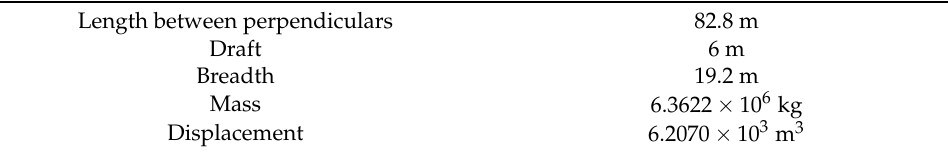
Table 3. Main particulars of the supply vessel in DP_MotionRAO.